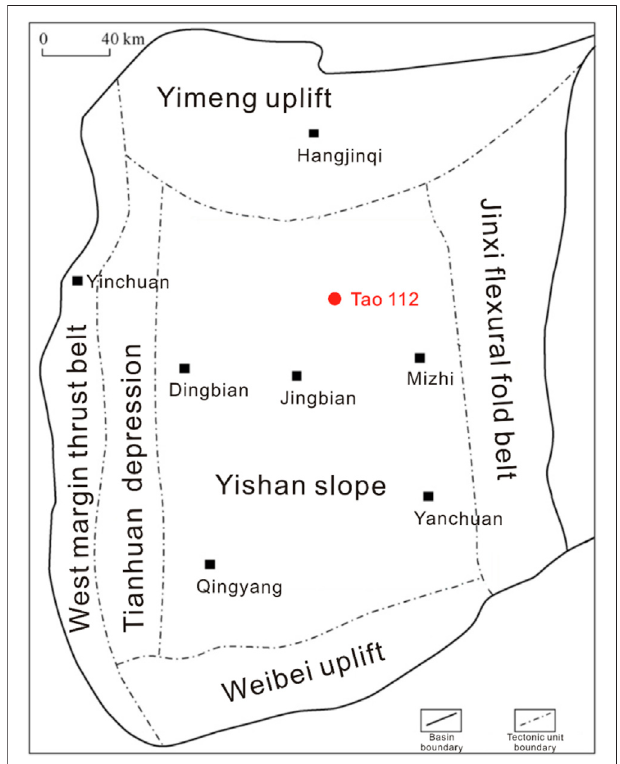
FIGURE1| Basinstructure